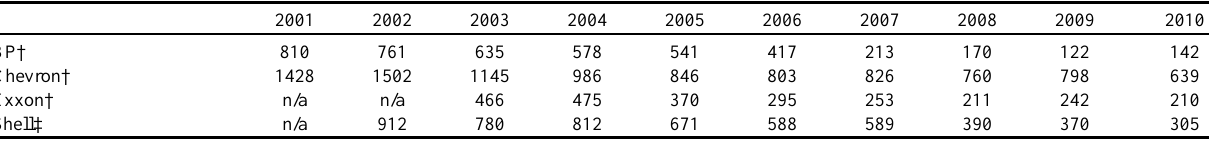
Table 3 . Number of self-reported oil spills by selected companies, 2001-2010.